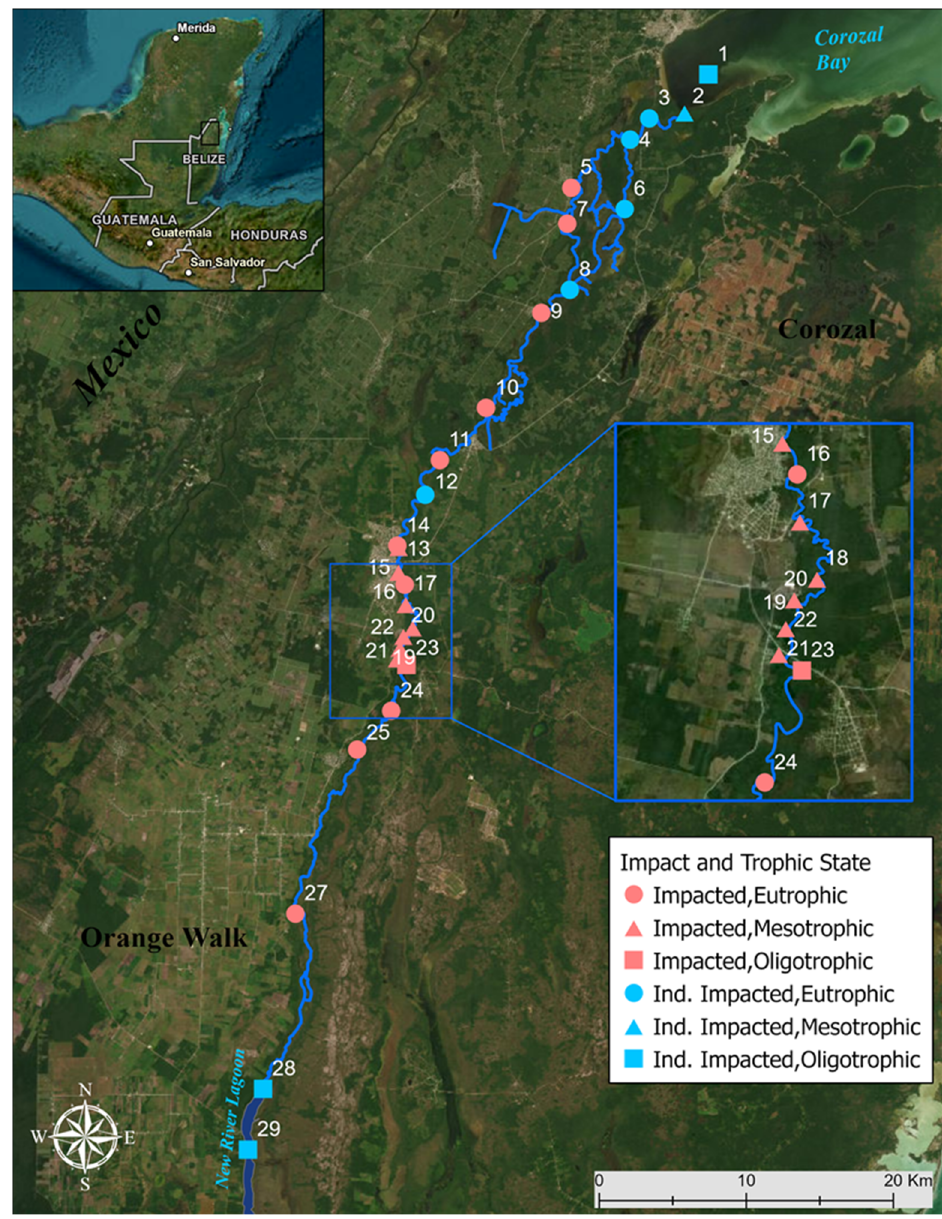
Figure 1. Map of 29 sample sites, with site 26 removed, along the New River (Blue line). New River runs through three Belize districts (Orange Walk, Belize, and Corozal) from New River Lagoon to Corozal Bay. Legend demonstrates trophic state and impact of sampled sites.